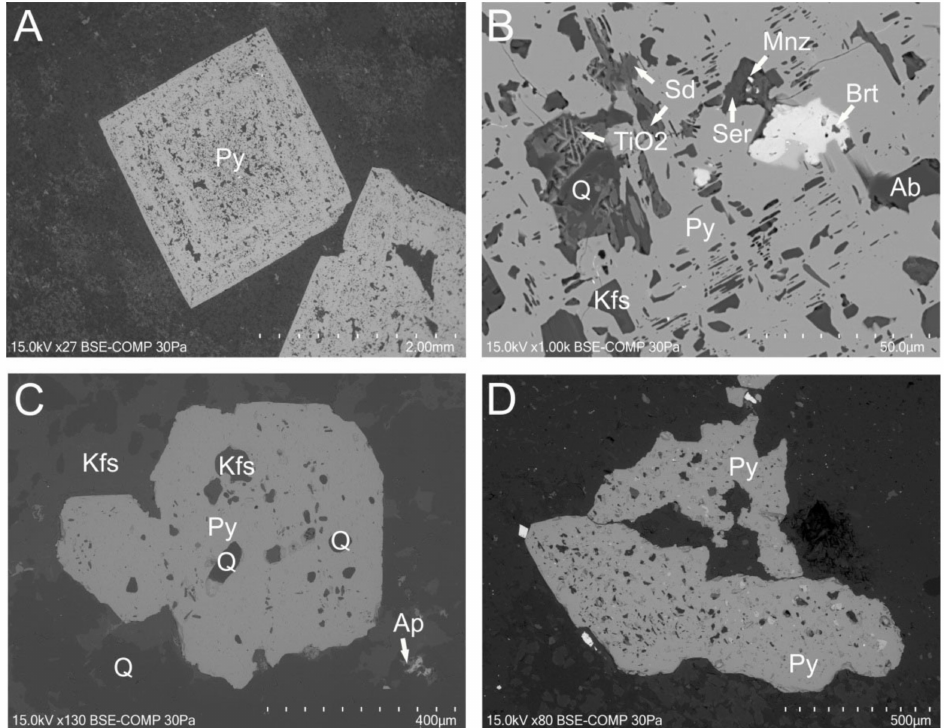
Figure 10. ( A – D ) SEM back-scattered images of Py-V (metasomatic pyrite). Abbreviations: Py—pyrite, Sd—siderite, Ser—sericite, Brt—barite, Ab—albite, Kfs—K-feldspars, Q—quartz, TiO 2 —rutile/anatase,